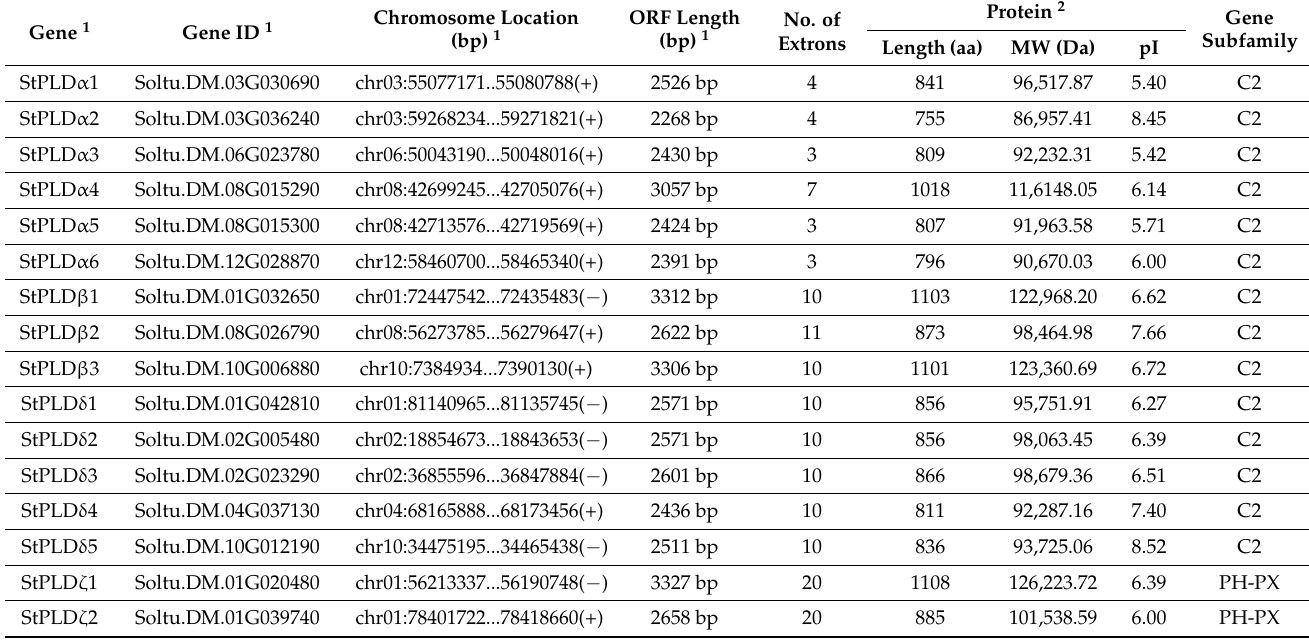
Table 1. The PLD genes in potato and properties of the deduced proteins ( Solanum tuberosum